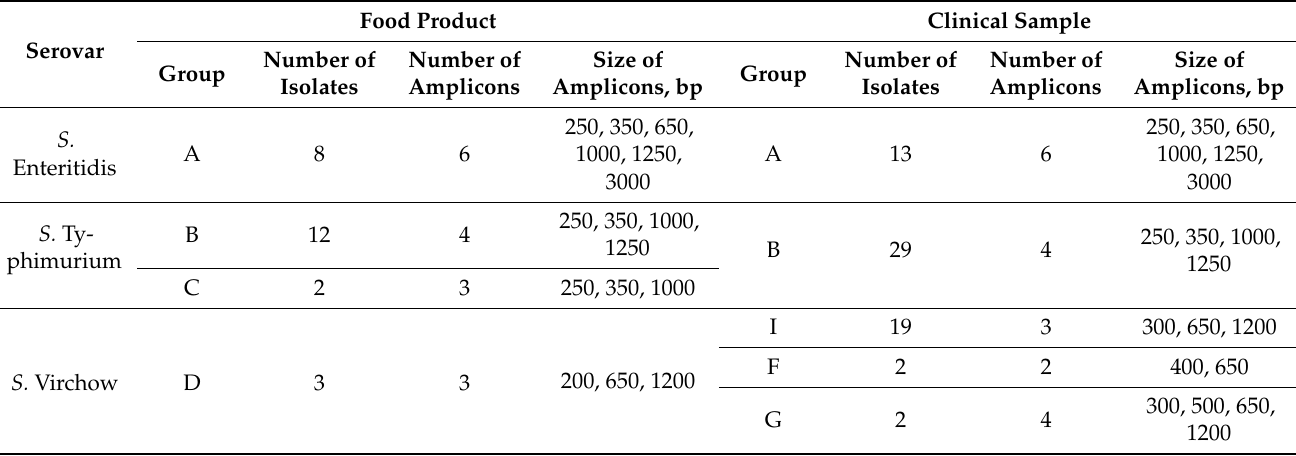
Table 6. Typing of Salmonella enterica strains by RAPD PCR.